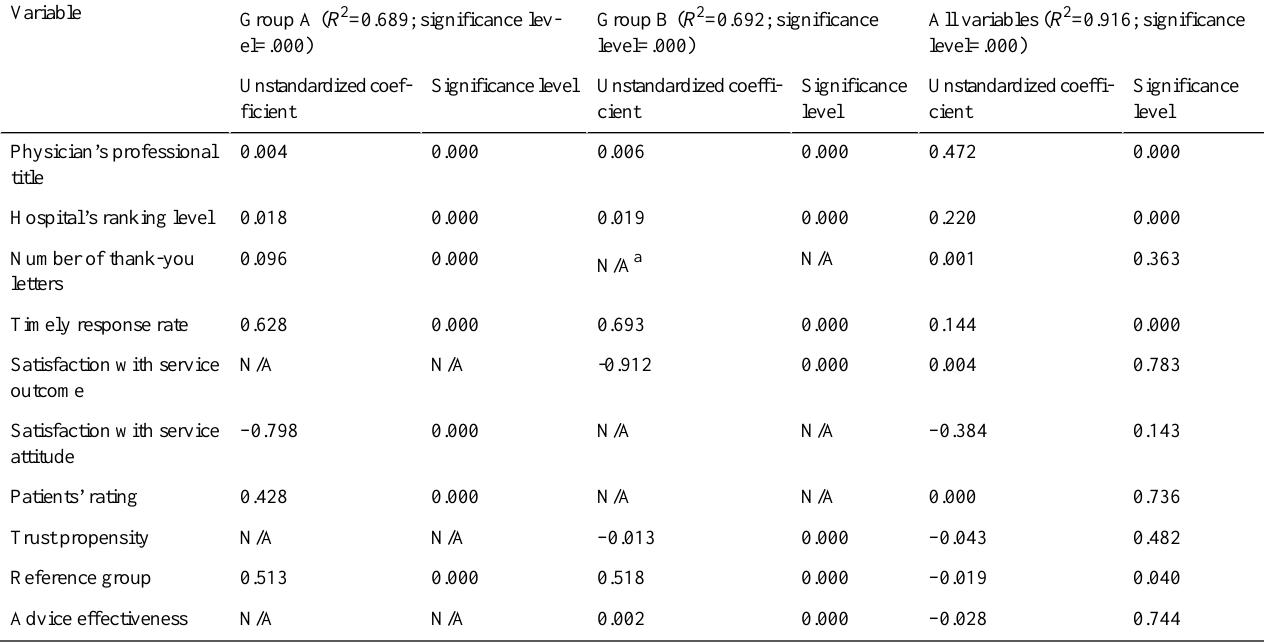
Table 4. Results of the regression